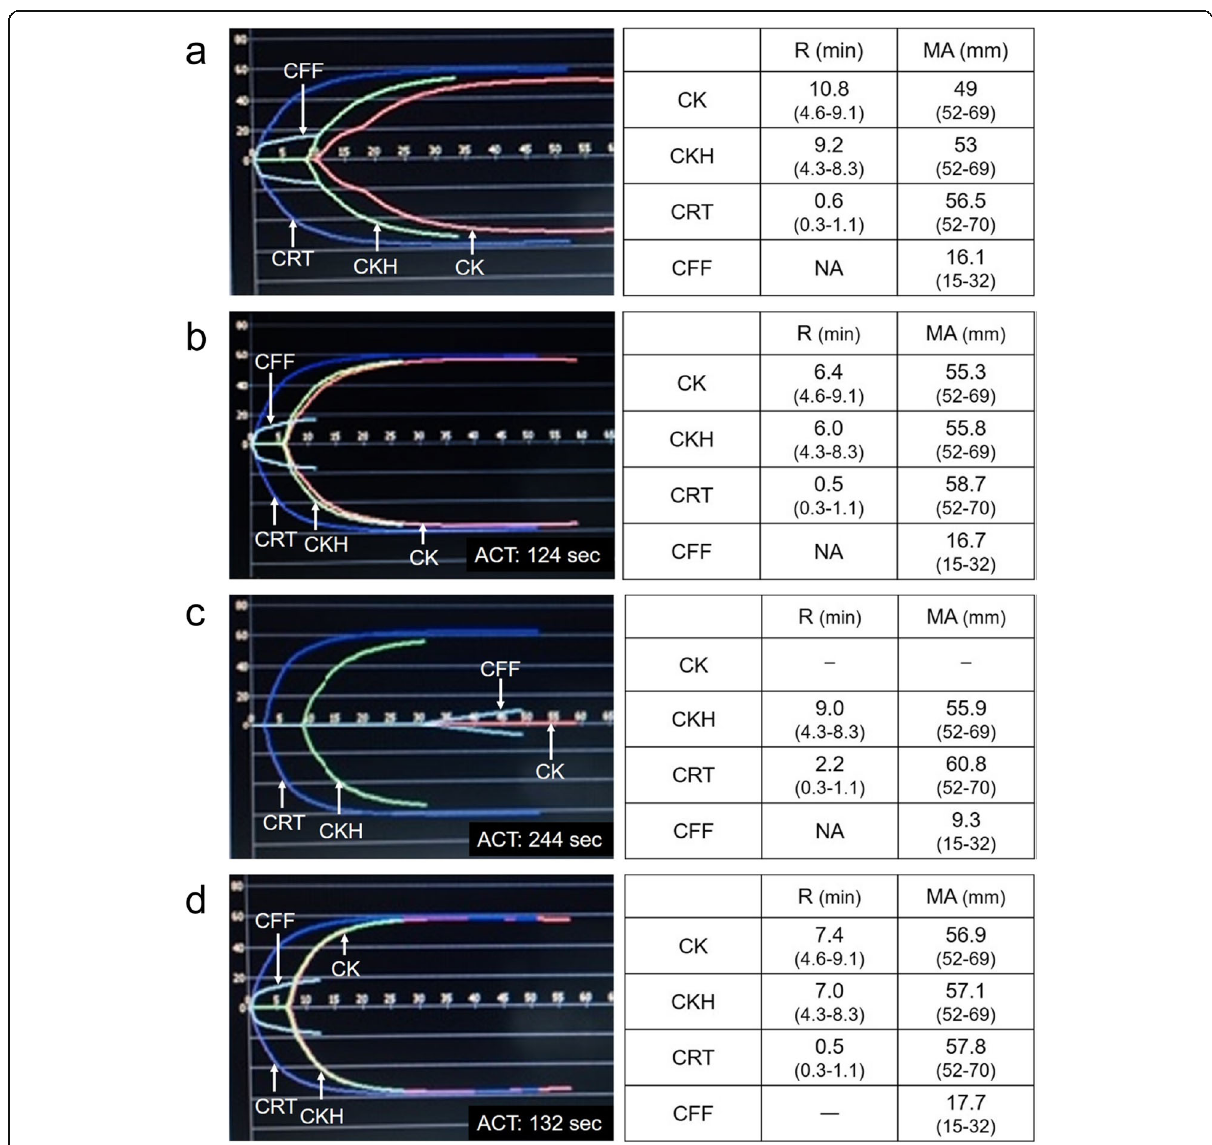
Fig. 2 TEG waveforms and numerical values of TEG parameters. a TEG data before administration of FVIII concentrate. The R values for both CK and CKH were prolonged, owing to FVIII deficiency. b TEG data after FVIII replacement. The R values for both CK and CKH became normal. c TEG data after heparin administration. The R value for CK was significantly prolonged, owing to the effect of heparin, although that for CKH was also prolonged by 0.7 min. d TEG data after protamine administration. The R values for both CK and CKH were normal. All TEG parameters showed normal values, indicating adequate heparin reversal and preserved levels of coagulation factors including FVIII. Reference ranges for each parameter are indicated within brackets. FVIII, factor VIII; MA, maximum amplitude; R, reaction time; TEG, thromboelastography; NA, not